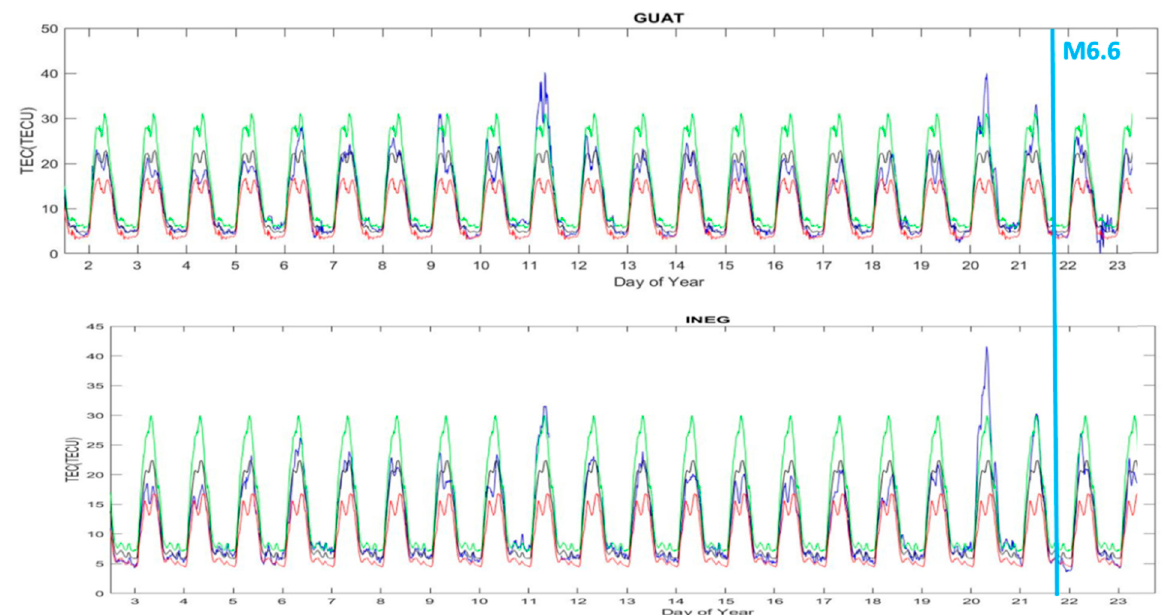
Figure 4. Similar as Figure 2, but for the 6.6 Mw Mexico earthquake on 21 January 2016 (shown by blue vertical line). TEC variations at 2 GNSS stations (GUAT outside and INEG inside the preparation area) for 18 days before, during and 2 days after the earthquake.